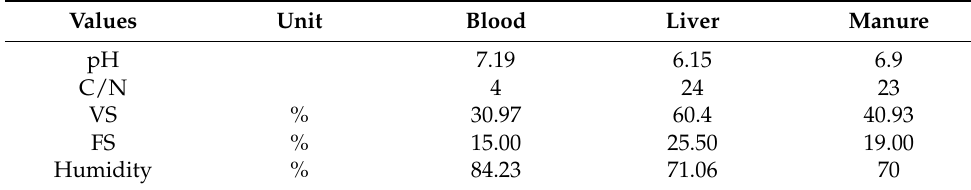
Table 3. Characteristics of the residues used in the six tests.